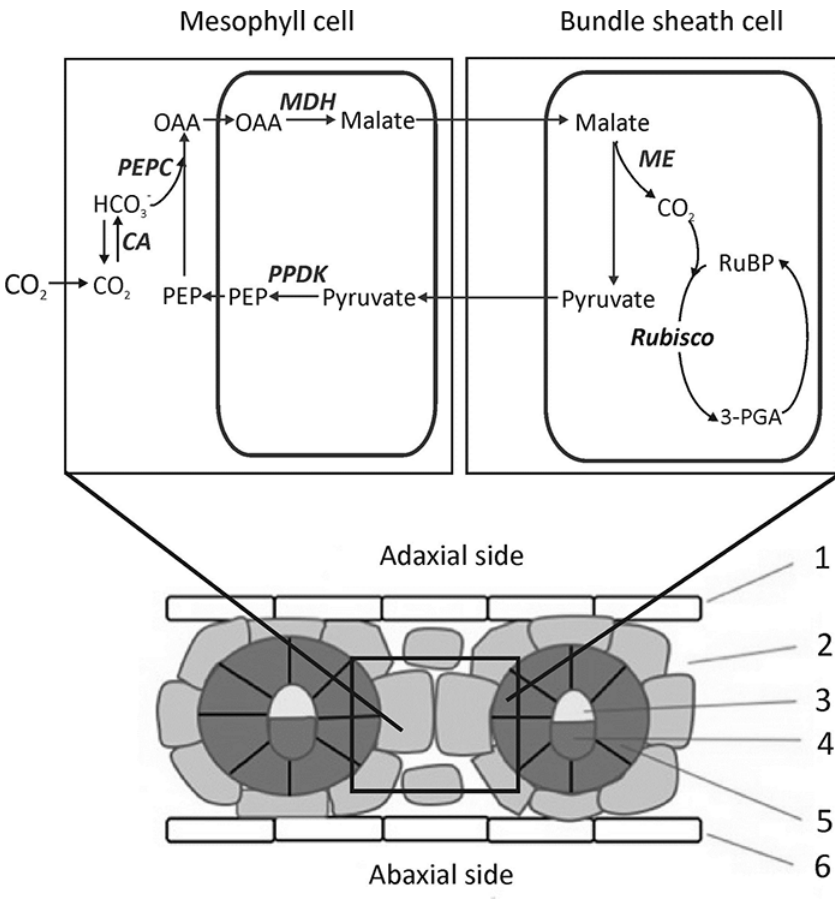
Figure 1 Leaf structure and C4 metabolic pathways of maize [NADP-malic enzyme (NADP-ME) type]. Enzymes: carbonic anhydrase (CA), phosphoenolpyruvate carboxylase (PEPC), malate dehydrogenase (MDH), NADP-ME and pyruvate, and orthophosphate dikinase (PPDK). Labels: 1, 6 – epidermis; 2 – mesophyll cell; 3 – xylem; 4 – phloem; and 5 – bundle sheath